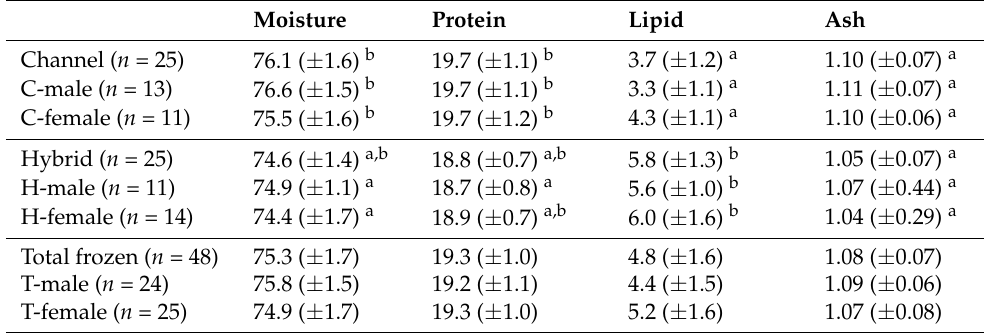
Table 8. Proximate compositions (wet weight basis) of raw frozen catfish